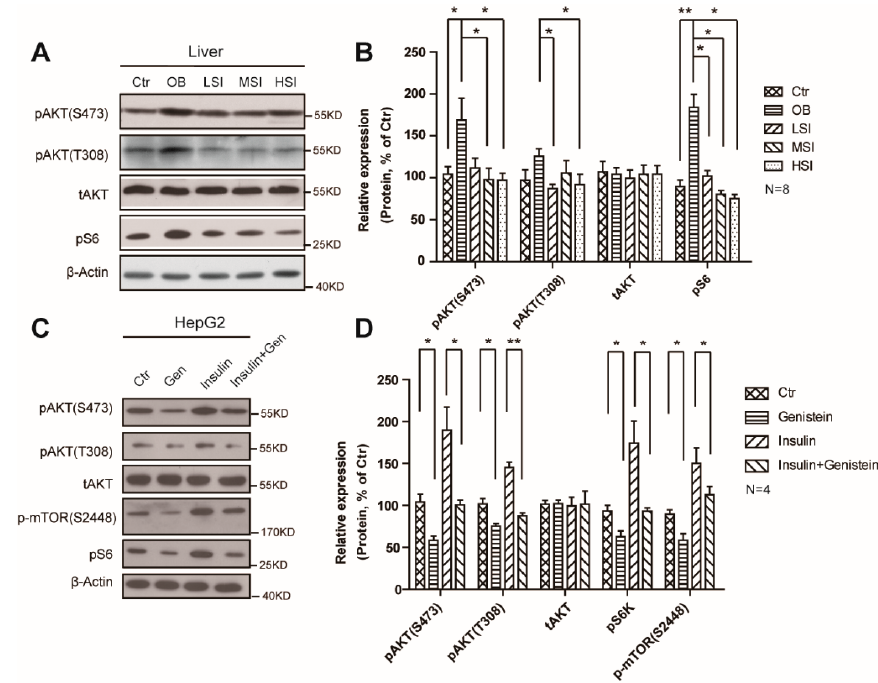
Figure 4. Soy isoflavones suppress the mTORC1 activity via AKT pathway. ( A , B ) Western blots and quantification show a suppression function of soy isolflavones on mTORC1 activity in DIO rats; ( C , D ) Western blots and quantification show a suppression function of soy isoflavones on mTORC1 activity in HepG2 cells. Error bars indicate SEM. * p < 0.05, ** p < 0.01.